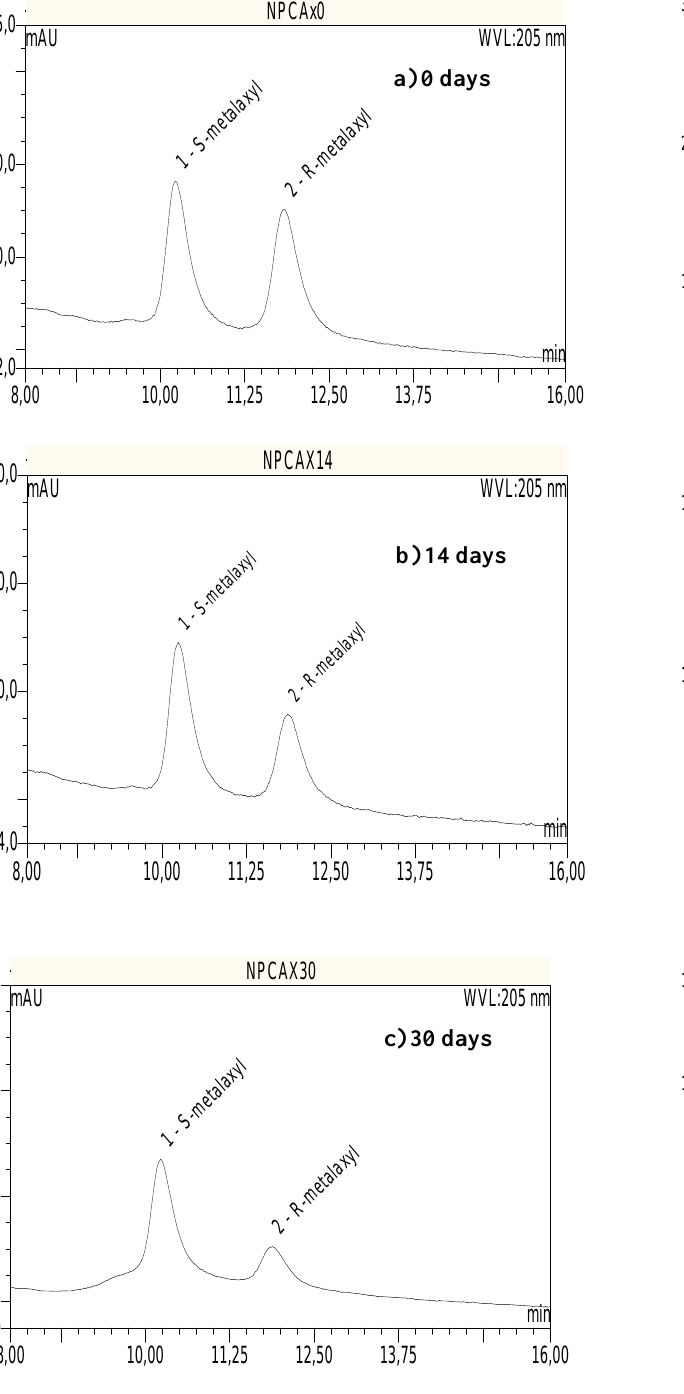
Figure 3: HPLC-DAD chromatograms showing elution of R and S-metalaxyl in the Cameroonian soil after a) 0; b) 75; and c) 120 days of